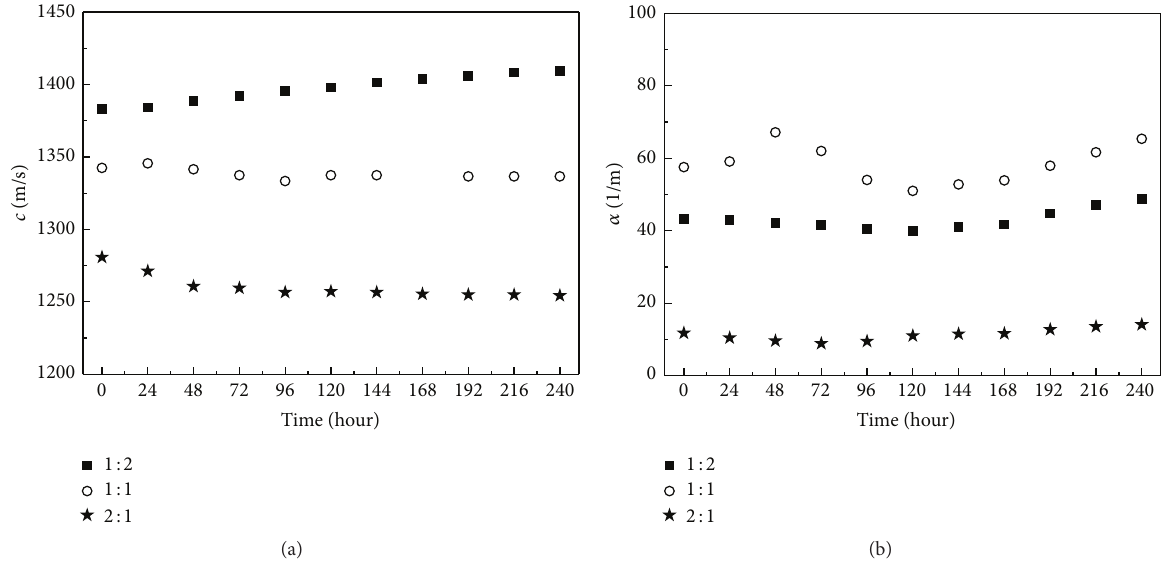
Figure 6: (a) The ultrasonic wave velocity and (b) attenuation, as a function of time for different oil/water volume ratios.